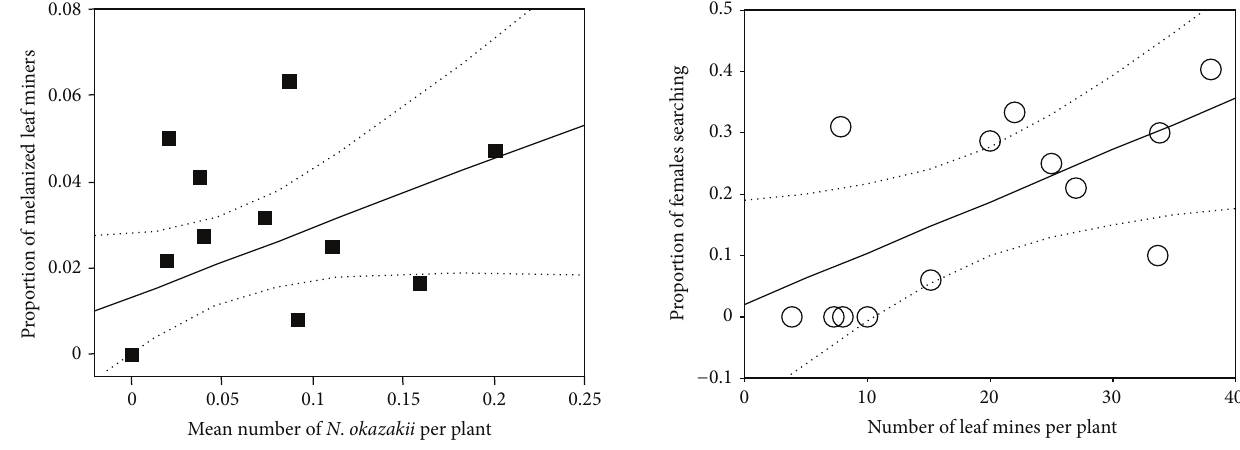
Figure 3: Relationship between mean numbers of melanized leaf miner larvae per plant and mean numbers of Neochrysocharis okazakii per plant. Dot lines indicate 95% confidence intervals.